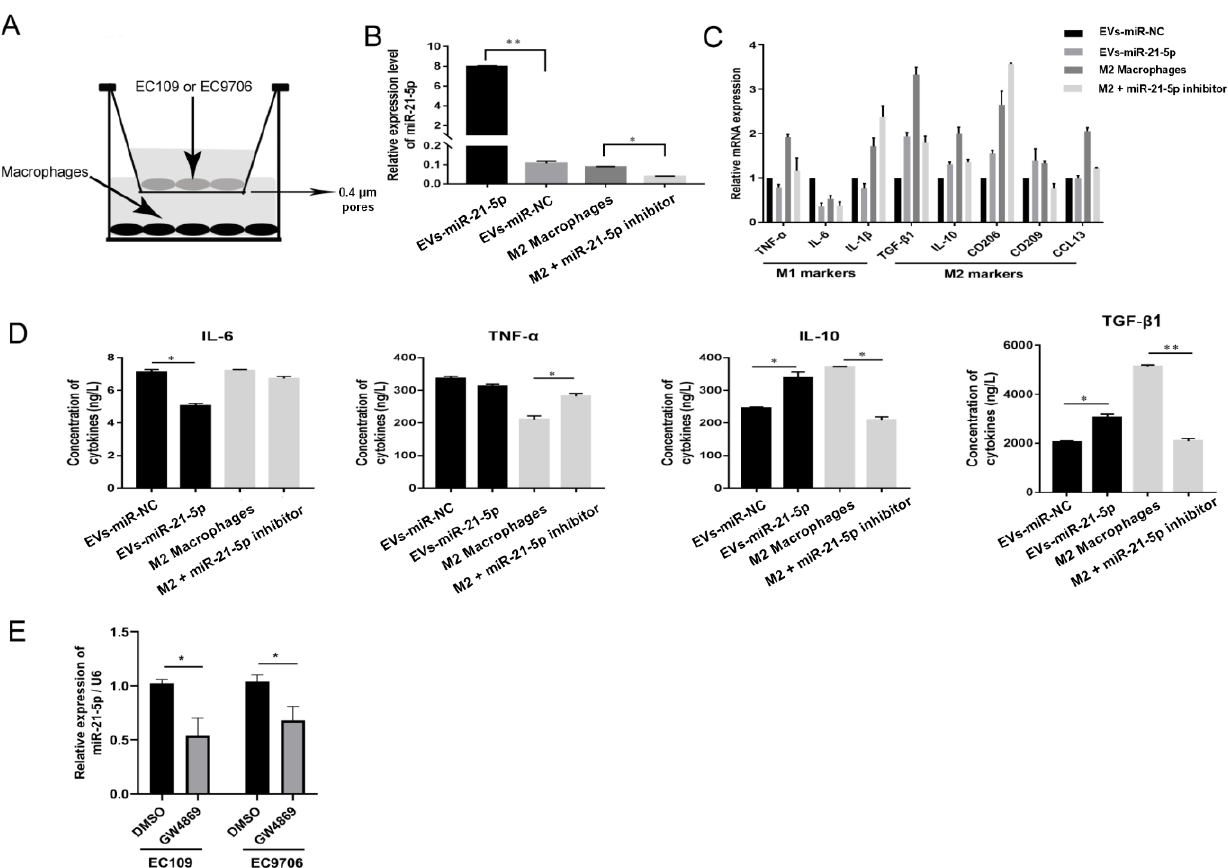
Figure 4. EVs-miR-21-5p promote M2 macrophage polarization. ( A ) Schematic design of the Transwell experiments. ( B ) Expression of miR-21-5p in macrophages in the coculture system as detected by q-RT-PCR. ( C ) The mRNA expression of M1 and M2 macrophage markers was detected by q-RT-PCR. ( D ) The protein expression of M1 and M2 macrophage markers IL-4, TNF-α, IL-10, and TGF-β were measured by ELISA. ( E ) Relative expression of miR-21-5p in the culture supernatant of EC109 and EC9706 treated with GW4869. * p < 0.05; ** p < 0.01. The F - and t -tests were applied to assess statistical significance in group comparisons. Error bars indicate mean ± SD. EVs-miR-NC, EC109 cells were transfected with miRNAs mimic-NC for 48 h and cocultured with PMA-treated macrophages for another 24 h. EVs-miR-21-5p, EC109 cells were transfected with miR-21-5p mimic for 48 h and cocultured with PMA-treated macrophages for another 24 h. M2 macrophage, 100 ng/mL PMA was added to THP-1 cells for 24 h, incubated with 20 ng/mL IL-4 for another 24 h, and transfected with miRNAs inhibitor-NC for 48 h. M2 macrophage + miR-21-5p inhibitor, M2 macrophage was transfected with miR-21-5p inhibitor for 48 h.